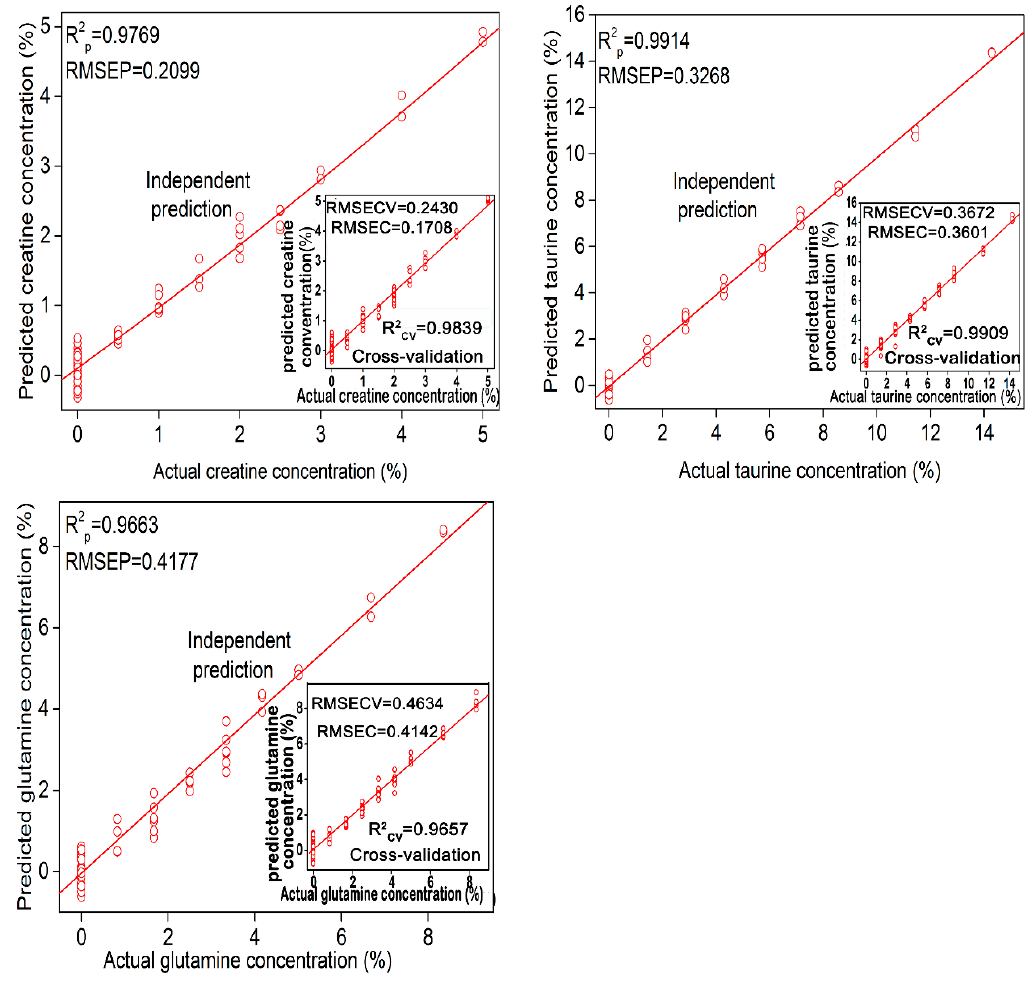
Figure 3. The partial least squares regression (PLSR) results of glutamine, creatine and taurine in the specific regions.